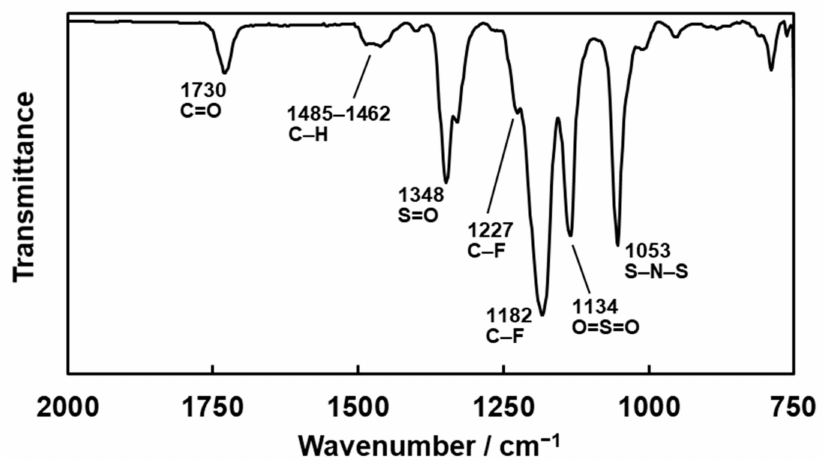
Figure 3. Attenuated total reflectance (ATR)/Fourier transform infrared spectroscopy (FTIR) spectra of the product. The grafted side of the poly( N , N -diethyl- N -(2-methacryloylethyl)- N - methylammonium bis(trifluoromethylsulfonyl)imide) (DEMM–TFSI) sample (weight average molec- ular weight ( M w ), 1.73 × 10 6 ; dispersity ( M w / M n ), 1.16; and degree of polymerization, 4520) was directly allowed to put on the ATR